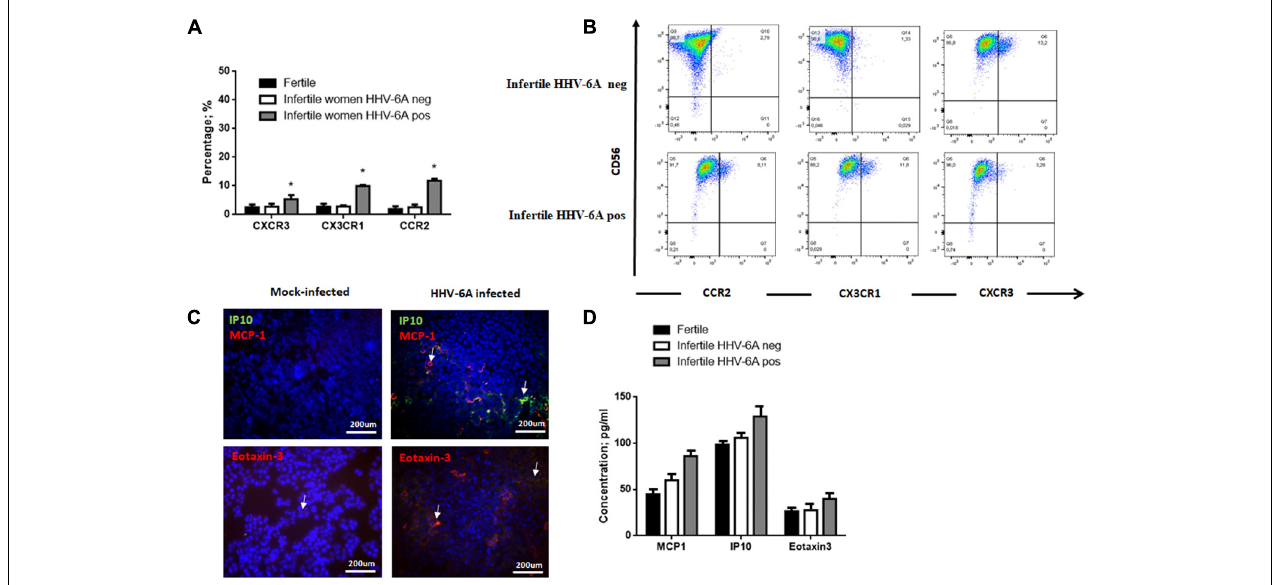
FIGURE 7 | eNK cell receptor repertoire expression. (A) eNK cells purified from endometrial biopsies were stained for surface expression of the indicated chemokine receptors using fluorochrome-conjugated antibodies and analyzed by flow cytometry. (B) Representative FACS dot plots gated on CD56pos CD3neg dNK cells are reported. One representative dot plot out of five independent experiments is shown. ∗ Significant p -value obtained by Student’s t -test. (C) Chemokine receptor ligand expression. MCP1 (Monocyte chemotactic protein 1, CCL2), IP-10 (Interferon gamma-induced protein 10, CXCL10) and Eotaxin-3 (CCL26) expression was evaluated in endometrial epithelial cells 7 d.p.i. White arrows indicate positive staining. Images were taken in fluorescence (Nikon Eclipse TE2000S) equipped with a digital camera. Original magnification 20 × . (D) Chemokine receptor ligand expression. MCP1 (Monocyte chemotactic protein 1, CCL2), IP-10 (Interferon